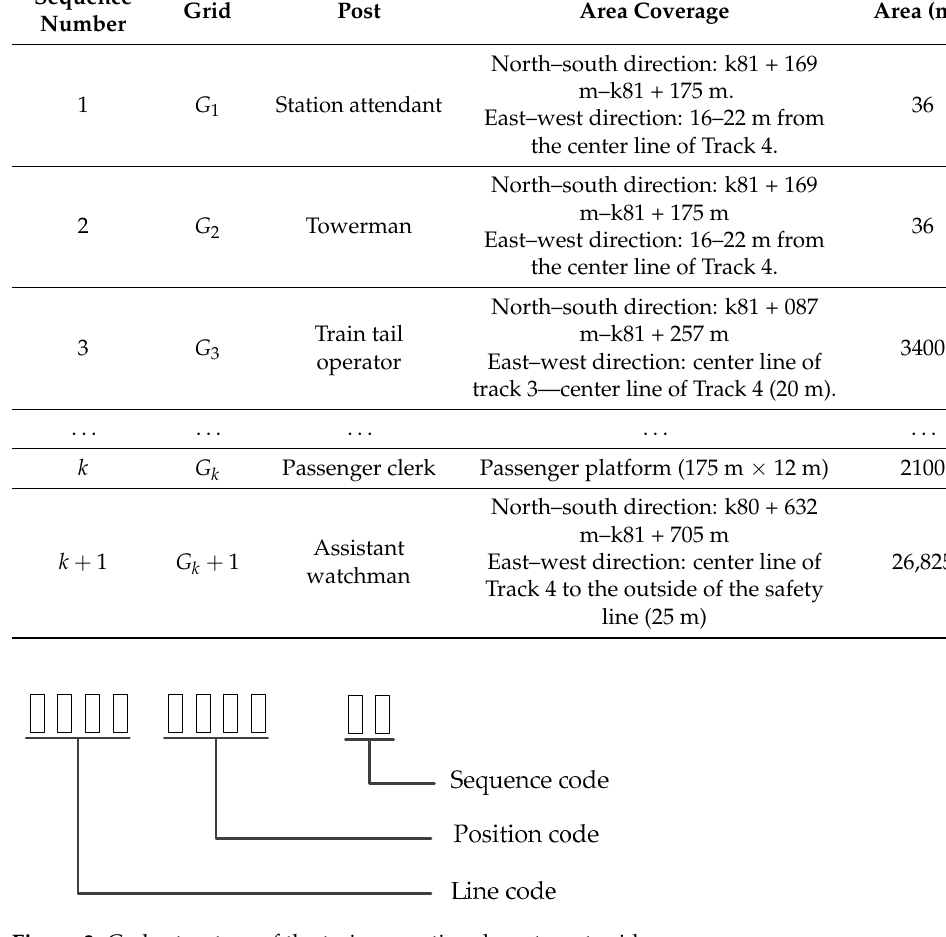
Figure 3. Code structure of the train operation department grid. Table 2. Classification of grid elements in the train operation